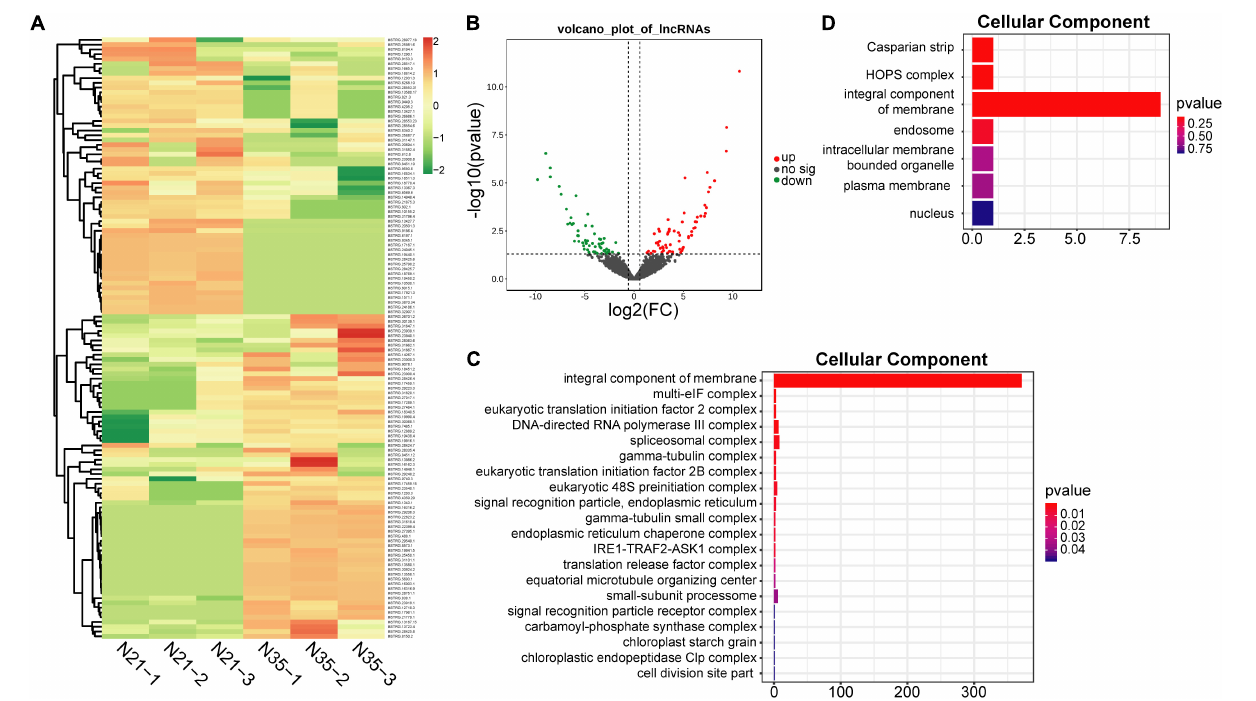
FIGURE 3 | Identification and functional analysis of DElncRNAs during nodule senescence. (A) Heat maps showed the fold changes of DElncRNAs. N21-1, N21-2, N21-3 and N35-1, N35-2, N35-3 represent three biological replicates of N21 and N35. (B) Volcano map of DElncRNAs. (C,D) GO analysis of cis and trans target genes of DElncRNAs. Top 20 terms of cellular component were